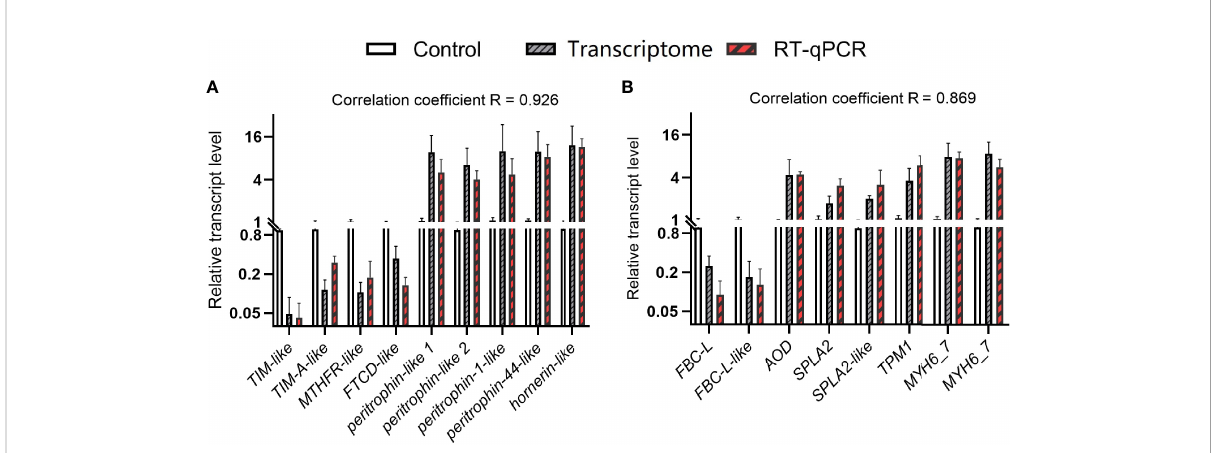
FIGURE 6 Comparison of gene expression patterns obtained by RNA-Seq and RT-qPCR. Values are means ± SD (n = 3). (A) D0 dsETH vs. D0 dsGFP . (B) D2 dsETH vs. D2 dsGFP